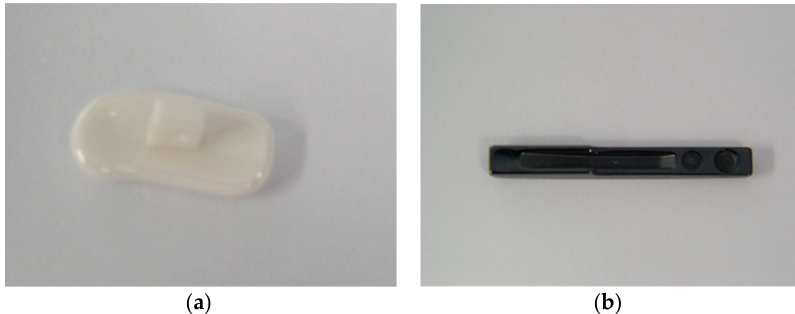
Figure 9. ( a )White ceramic watch link D1. ( b )Black ceramic watch bandD2.